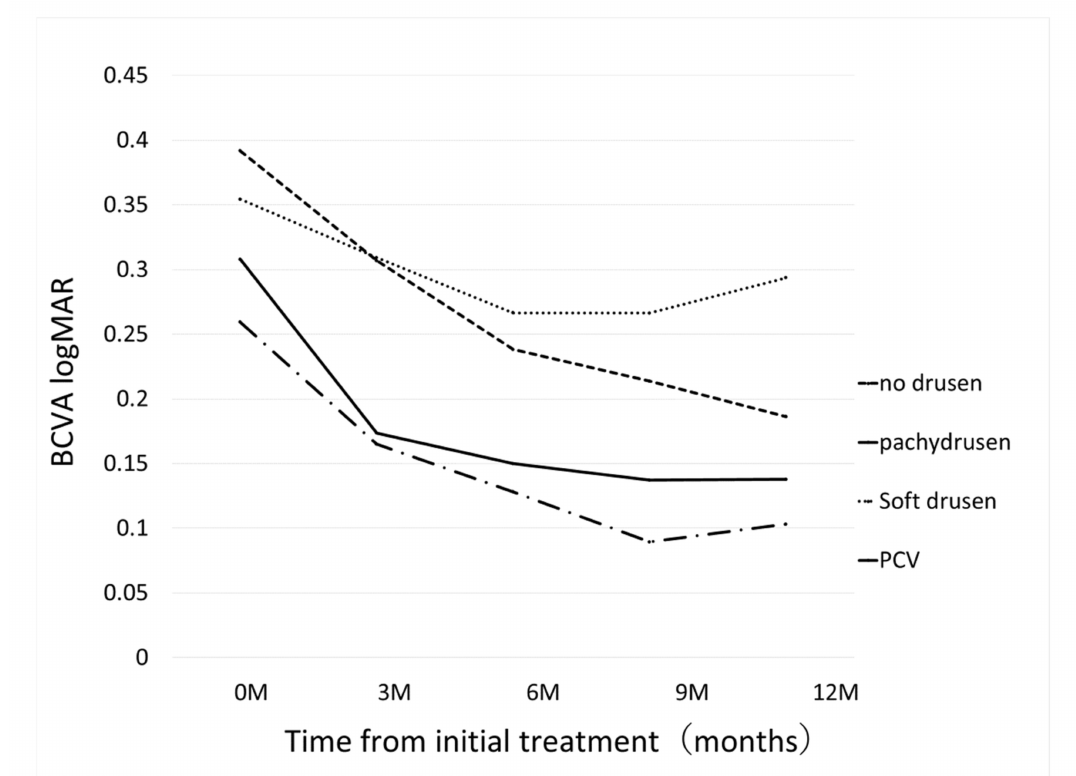
Figure 3. Changes of best-corrected visual acuity (BCVA) from initial treatment according to the groups. In pachydrusen group, BCVA improved from 0.26 ± 0.32 (baseline) to 0.17 ± 0.19 ( p = 0.276), 0.13 ± 0.20 (p = 0.11), 0.089 ± 0.16 ( p = 0.054), 0.10 ± 0.20 ( p = 0.081) at 3 months, 6 months, 9 months, and 12 months, respectively. In no drusen group, BCVA improved from 0.39 ± 0.38 (baseline) to 0.31 ± 0.34 ( p = 0.023), 0.24 ± 0.32 ( p = 3.8 × 10 -6 ), 0.21 ± 0.29 ( p = 8.25 × 10 -8 ), 0.19 ± 0.28 ( p = 4.8 × 10 -7 ) at 3 months, 6 months, 9 months, and 12 months, respectively. In soft drusen group, BCVA improved from 0.35 ± 0.29 (baseline) to 0.31 ± 0.35 ( p = 0.016), 0.27 ± 0.31 (p = 9.8 × 10 -3 ), 0.27 ± 0.34 ( p = 0.043), 0.29 ± 0.35 ( p = 0.14) at 3 months, 6 months, 9 months, and 12 months, respectively. In PCV / Scarring group, BCVA improved from 0.31 ± 0.35 (baseline) to 0.17 ± 0.19 ( p = 0.086), 0.15 ± 0.20 ( p = 0.019), 0.14 ± 0.16 ( p = 0.074), 0.14 ± 0.14 ( p = 0.054) at 3 months, 6 months, 9 months, and 12 months,